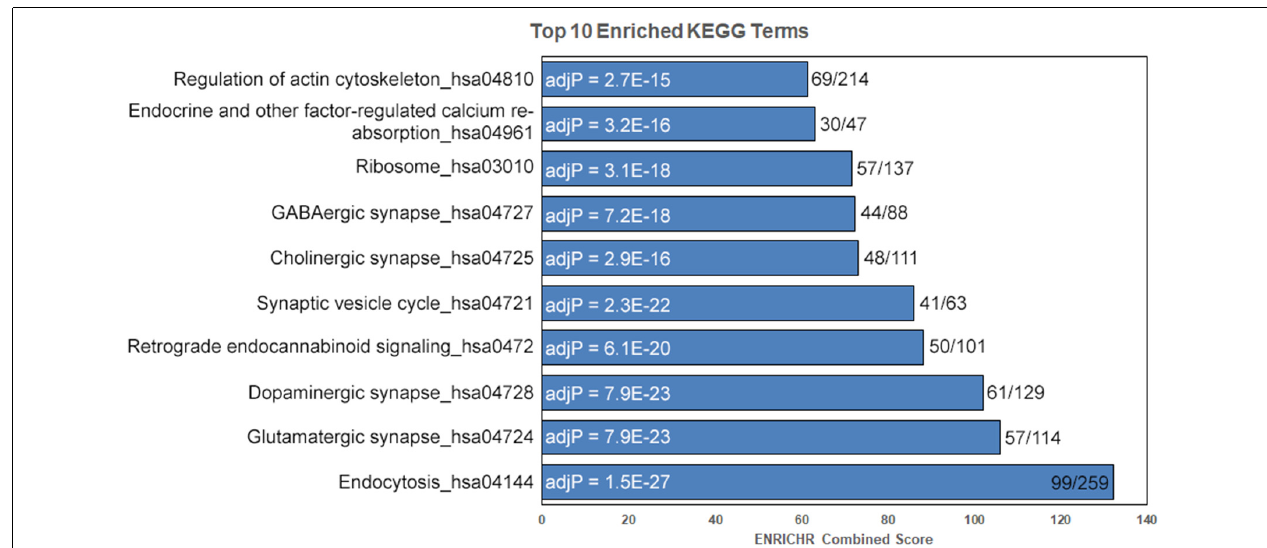
FIGURE 2 | Enrichment for key striatal signaling pathways. Following removal of mitochondrial proteins, enrichment analysis was performed on detected proteins using the ENRICHR web service. Enriched KEGG pathway terms are shown to the left and adjusted P -values (adjP) following correction for multiple testing are shown in the bars. The ratio of terms in our data set compared to the total number of KEGG terms is shown to the left of the bars. Terms sorted by ENRICHR Combined Score.